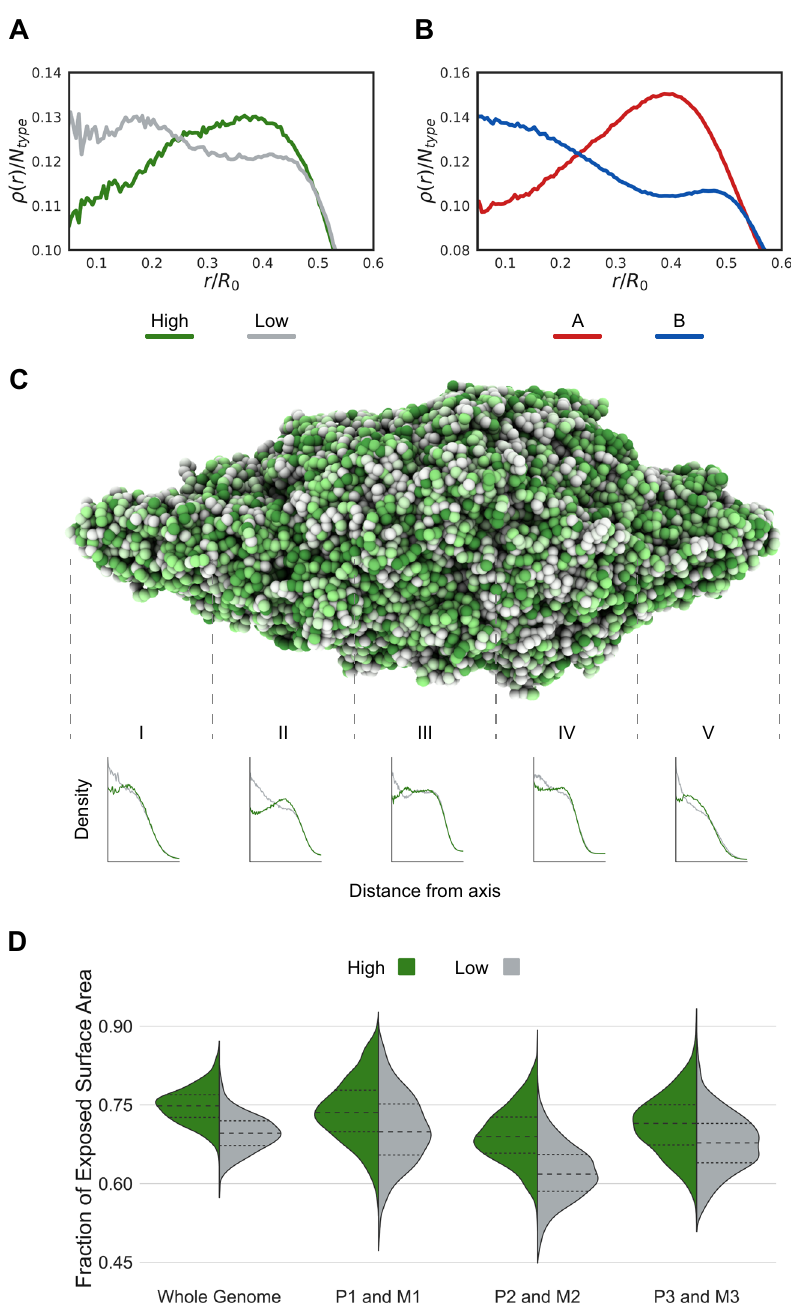
Fig. 3 | Loci characterized by high-intensity ATAC-seqsignalsareoftenlocated onthechromosomesurface.A RadialdensitydistributionforlowandhighATAC- seq signal intensity (gray and green lines). B Radial density distribution for chro- matin types A and B (red and blue lines). Analogous to High ATAC-seq signals, chromatin type A is often presented in the chromosome periphery. C Representative 3D structure of the Aedes aegypti full nucleus colored based on